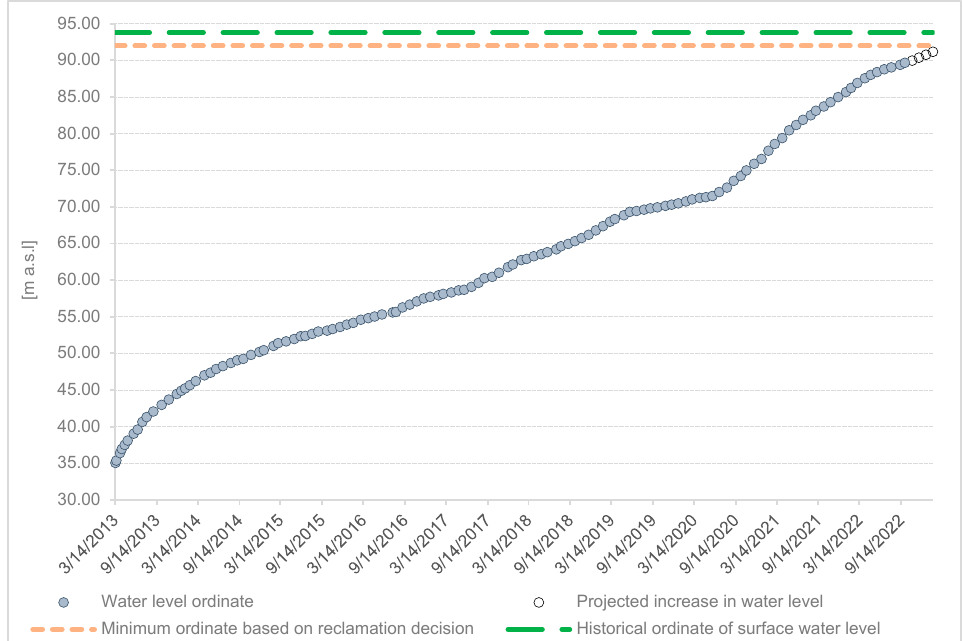
Figure 4. Changes in the location of the water level in the former opencast mine Kazimierz P ó łnoc (based on data of KWB Konin).